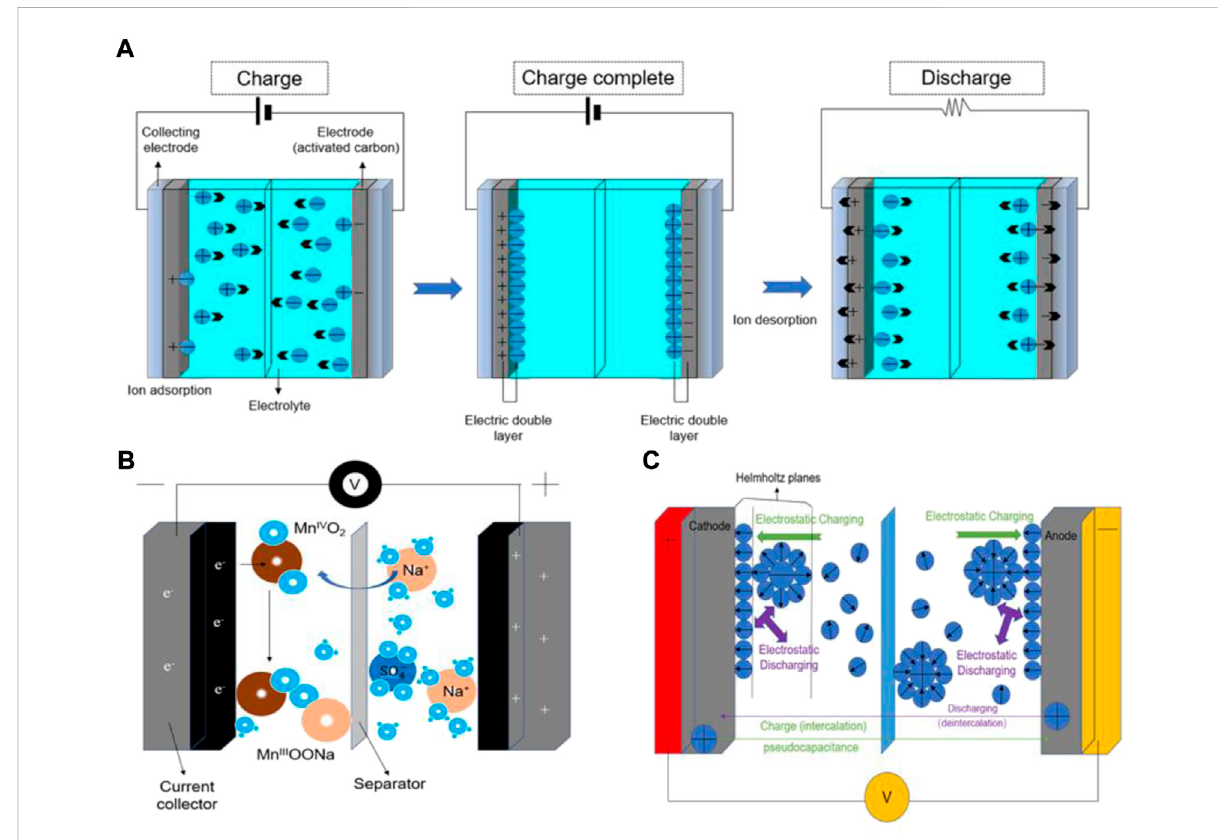
FIGURE 1 The working mechanism of supercapacitors. (A) Working principle of EDLC during charging and discharging, (B) pseudocapacitor, and (C) hybrid